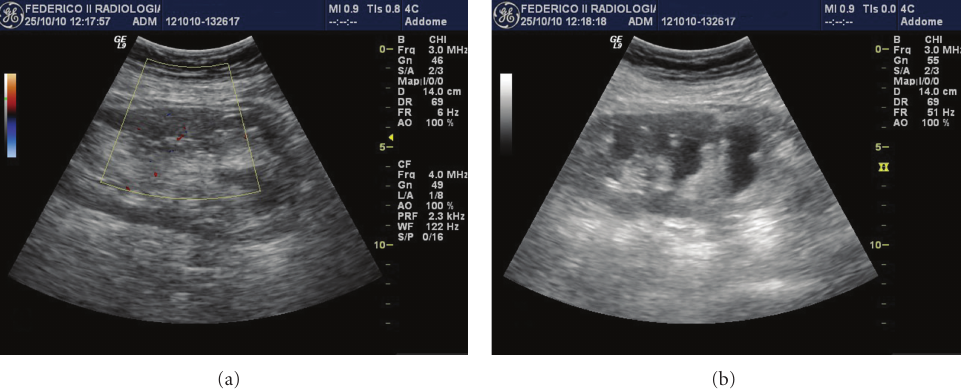
Figure 1: (a) US showing the highly echogenic appearance of renal sinus with fat tissue that covers most of renal surface. (b) Longitudinal scan of the transplanted kidney showing a discrete degree of hydronephrosis, more pronounced in the upper calyces.